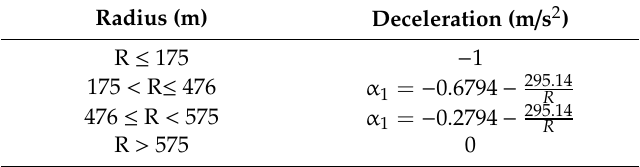
Table 4. Equation for calculating deceleration from starting point to midpoint of circular curve.